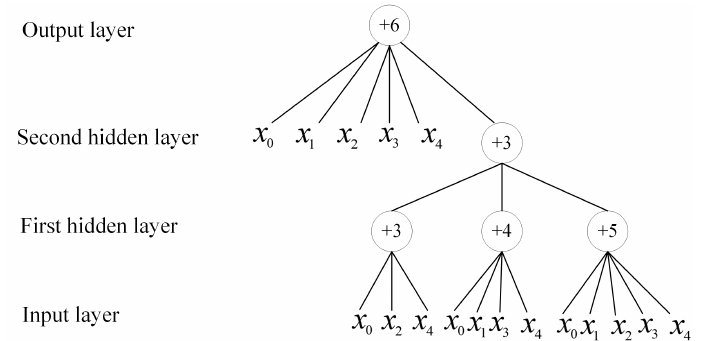
Figure 7. The trained structure of